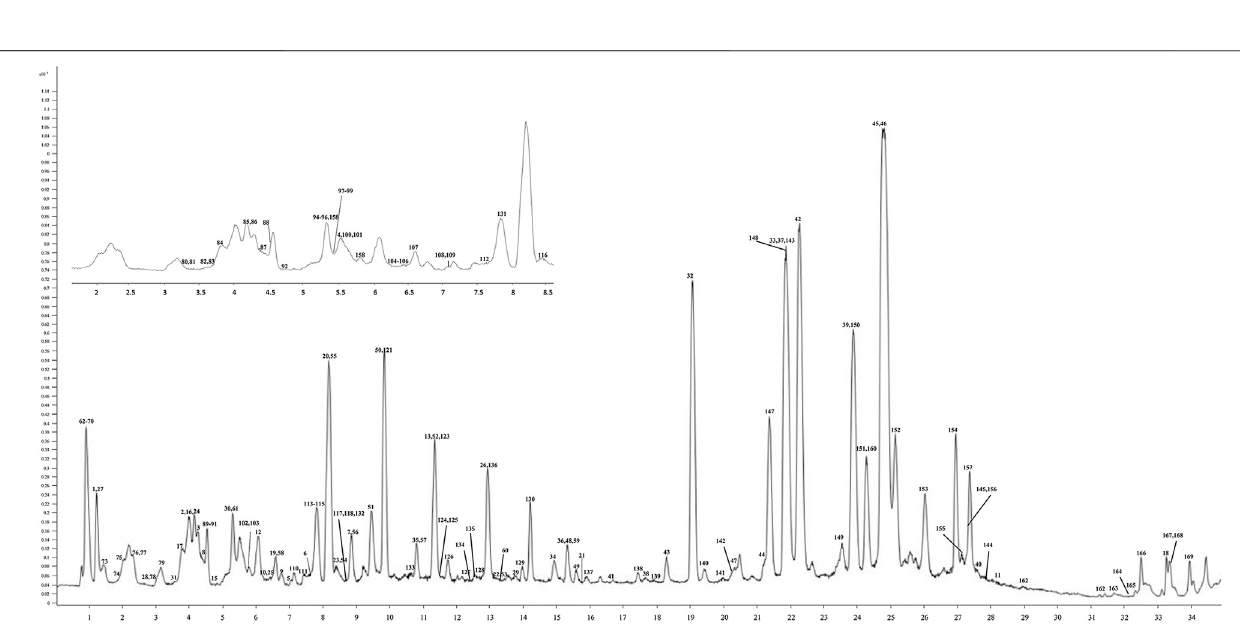
Frontiers in Pharmacology |